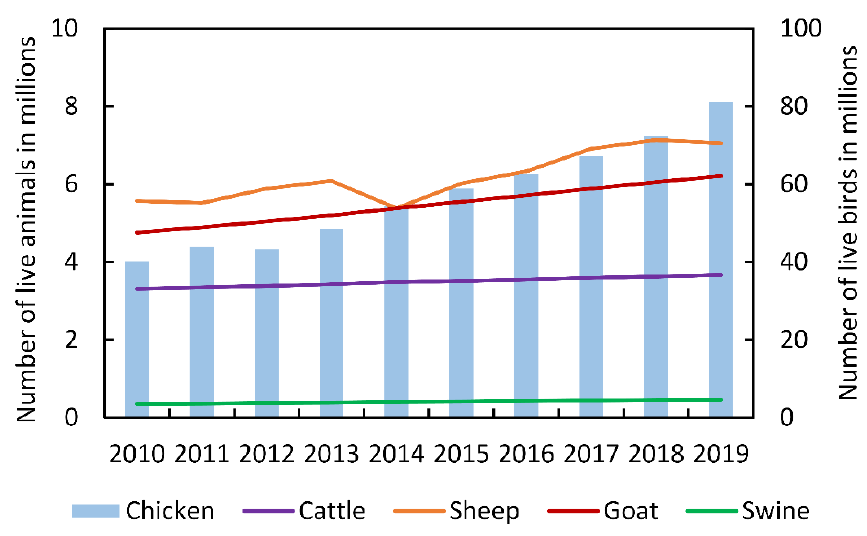
Figure 4. Total number of livestock species in Senegal during the period of 2010–2019 [47].